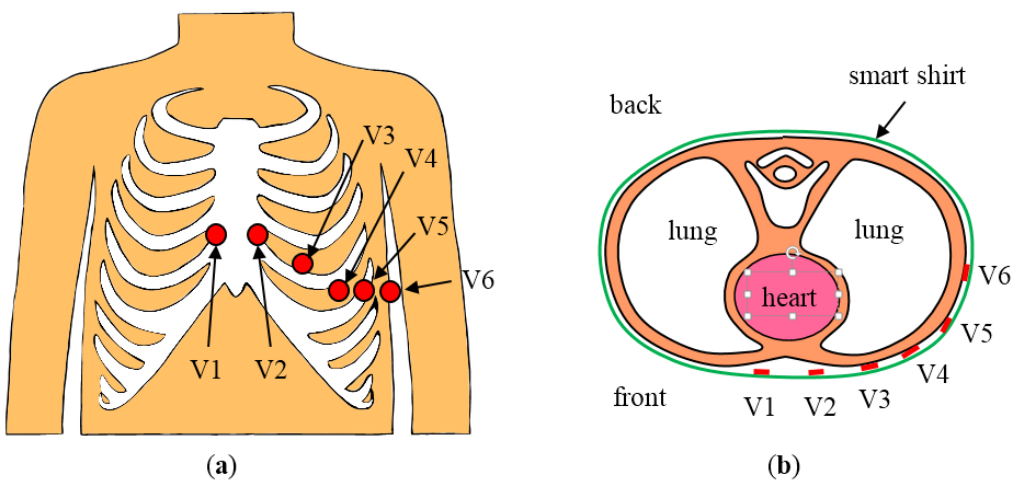
Figure 1. Placement of electrodes with unipolar precordial leads used to measure the ECG: ( a ) front view; ( b ) cross-sectional view of the